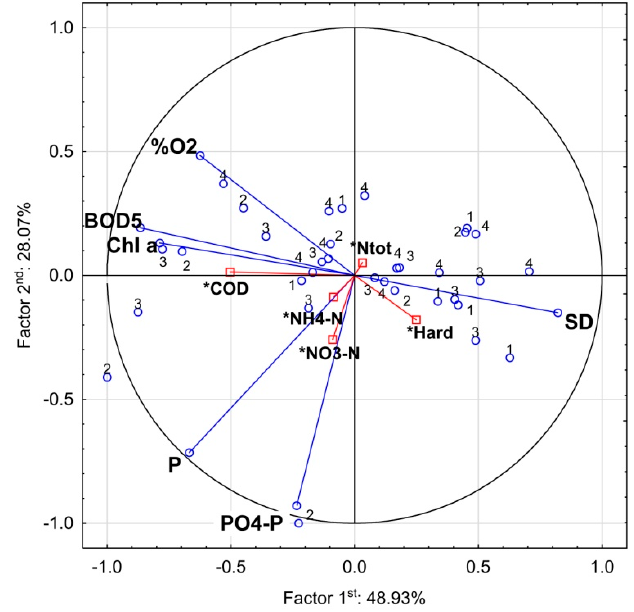
Figure 5. Principal component analysis for selected physicochemical water quality parameters (SD—